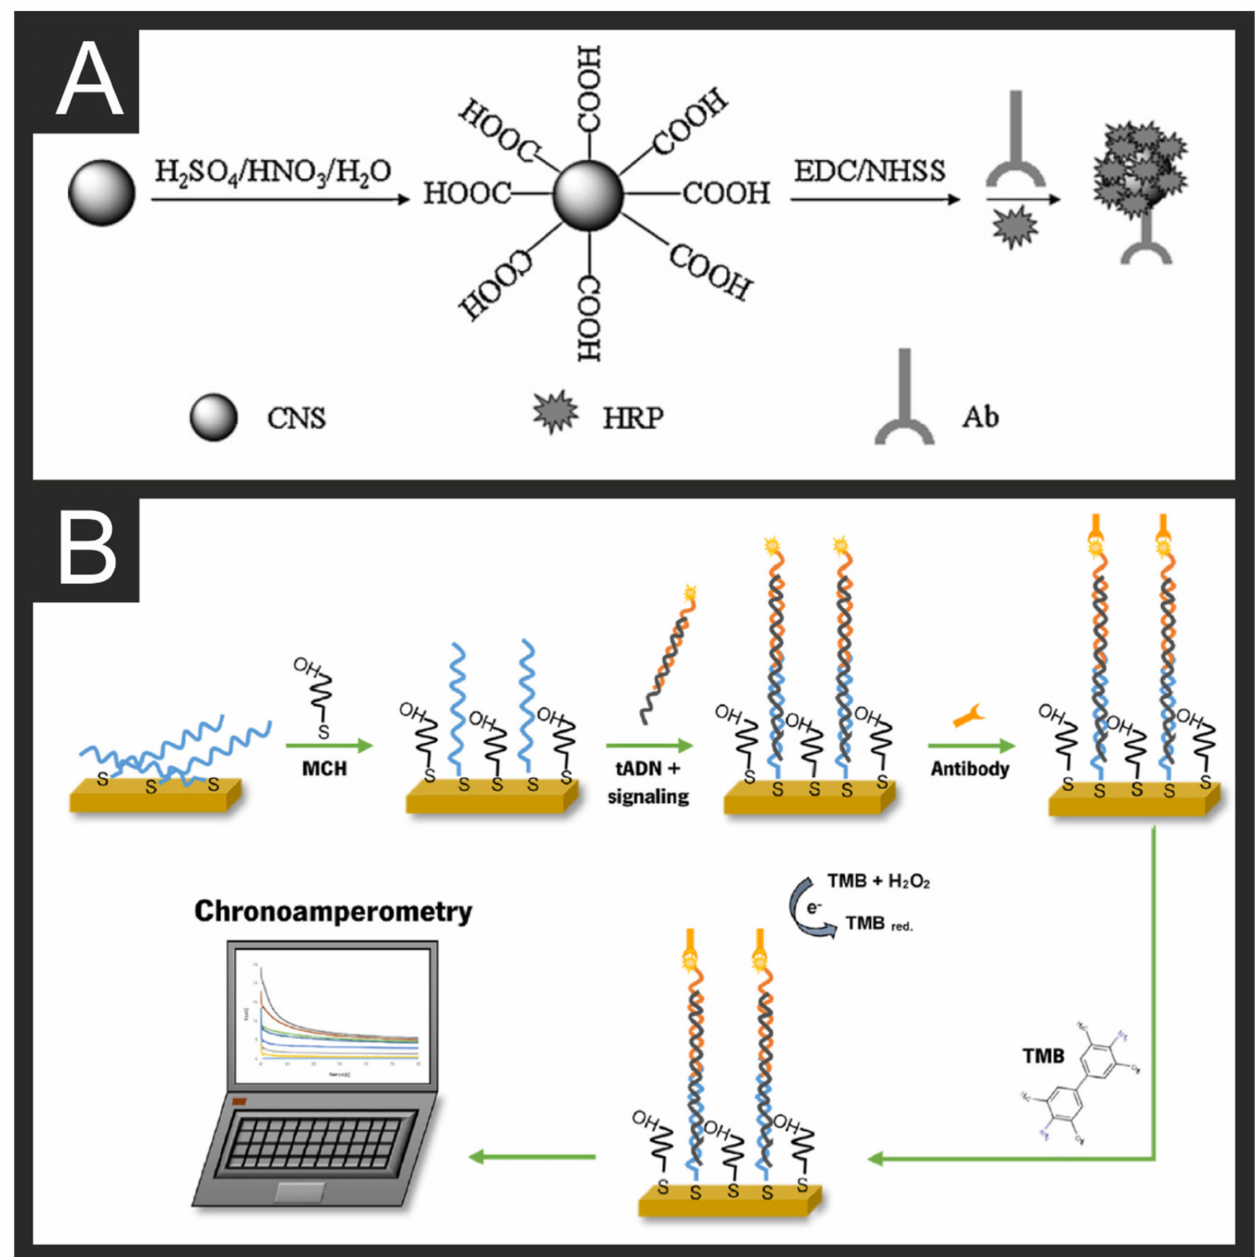
Figure 4. ( A ) Schematic illustration of the carboxylation procedures of CNS and the subsequent HRP-CNSs-Ab conjugation. Reproduced with permission from [47]. Copyright Elsevier 2013. ( B ) Schematic for the development of the electrochemical genosensor for A. minutum . Reproduced with permission from [49]. Copyright Elsevier